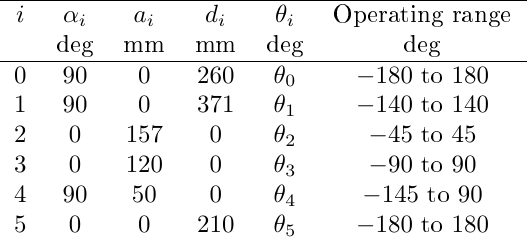
Tab. 1: Denavit-Hartenberg parameters of